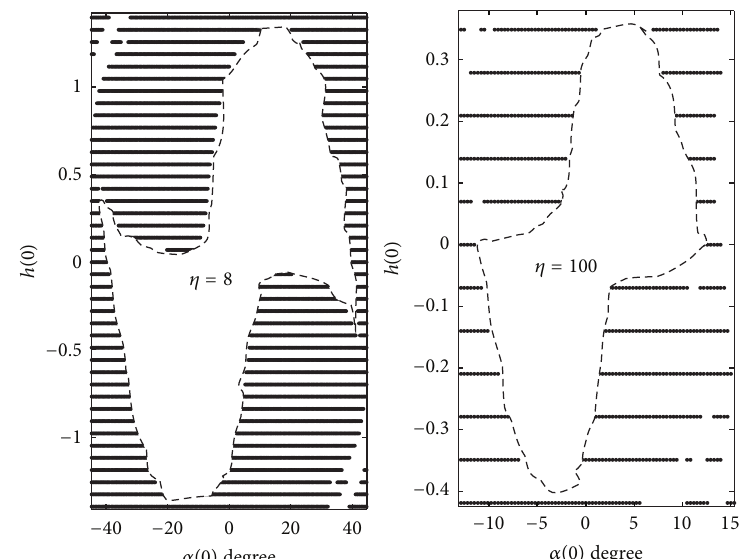
Figure 8: The convergent region for the stable LCO and fixed point of system (8) with 𝑈/𝑈 𝑓 = 0.7 ; shadow region denotes convergent points for the LCO while the blank for the fixed point.